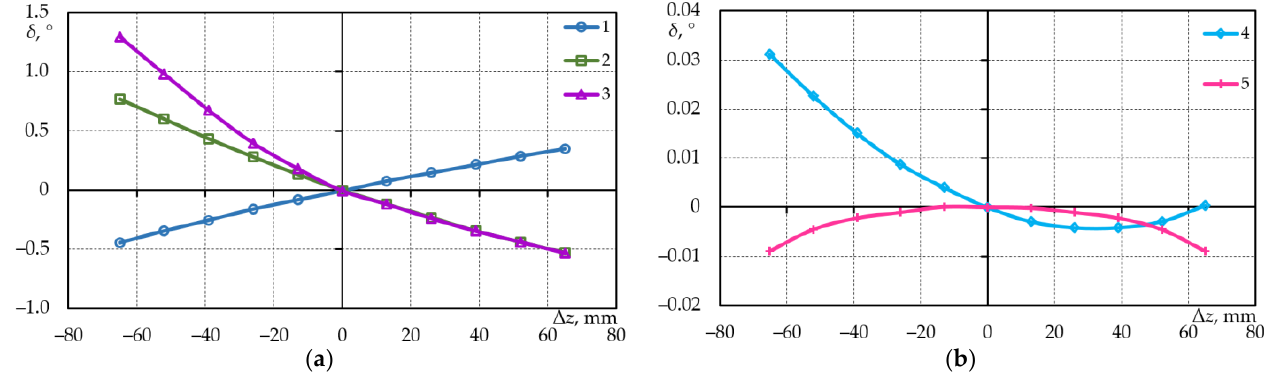
Figure 22. Dependence of the slip angle of the front ( a ) suspension and rear ( b ) suspension wheels on the vertical wheel travel (marking according to Table 2).